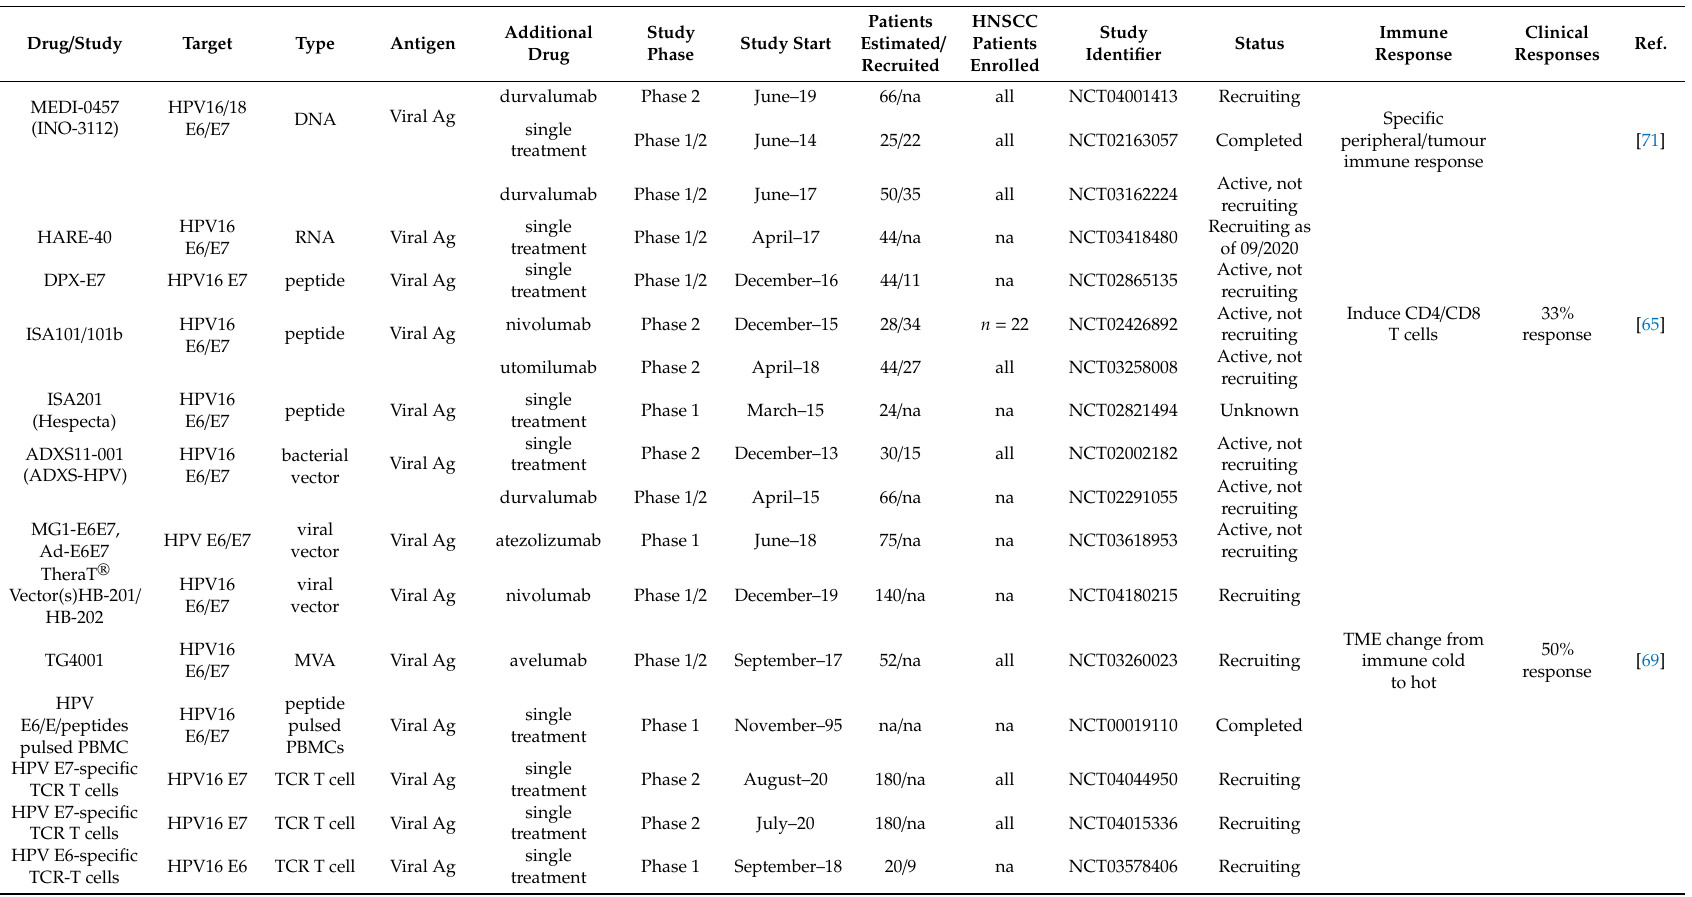
Table 1. Overview of completed and ongoing clinical trials targeting viral antigens in HNSCC